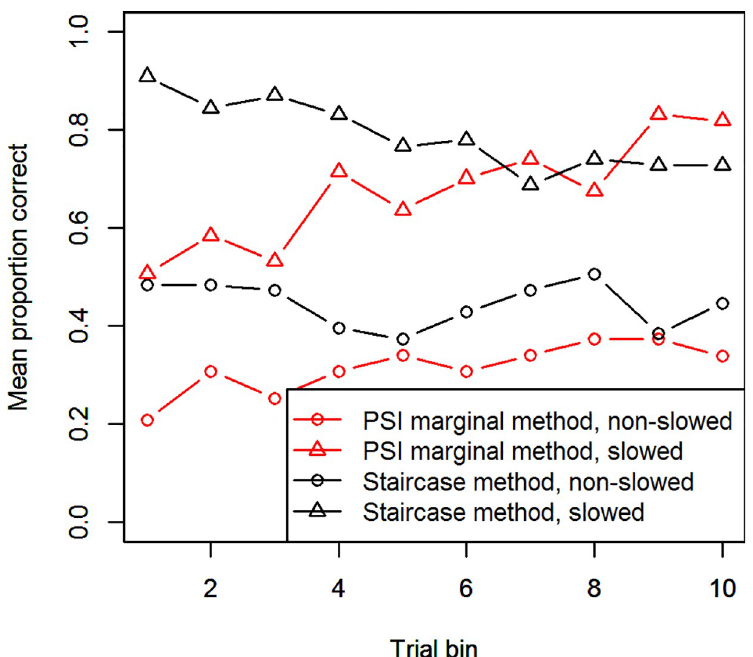
Fig 3. Accuracy throughout Experiment 1. The proportion of successful Change-trials (averaged over bins of 8 trials) of the PSI marginal and Staircase methods. Participants were split into two groups based on whether they showed substantial Go-response